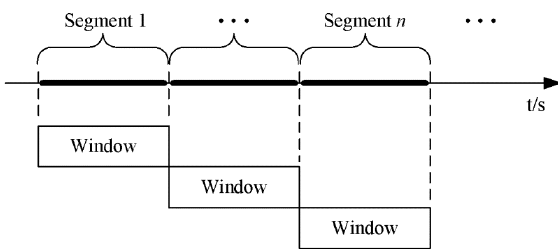
Figure 4. Data segmentation conducts by sliding window.